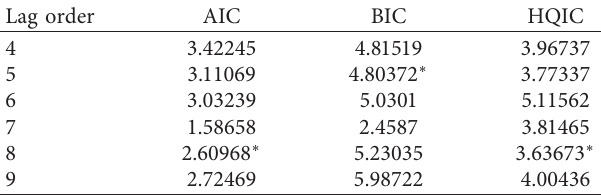
Table 4: Optimal lag order.